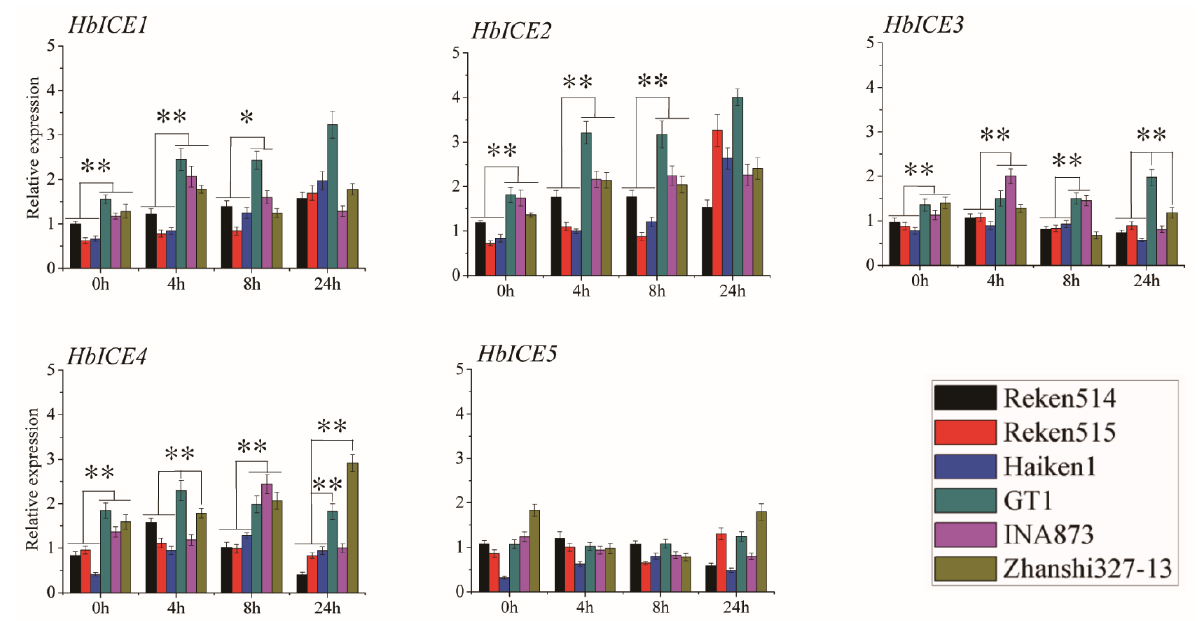
Figure 7. Expression profiles of five HbICEs genes in three cold-sensitive rubber tree clones (Haiken1, Reken514, and Reken515) and three cold-tolerant rubber tree clones (GT1, Zhanshi327-13, and INA873). The asterisks (**) and (*) respectively represented very significant difference ( p < 0.01) and significant difference ( p < 0.05).